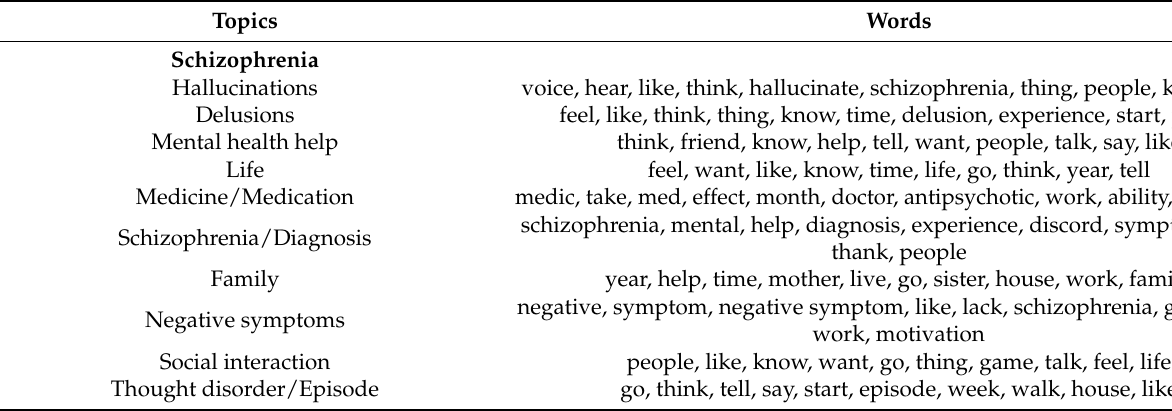
Table 3. Manually labeled topics and the top 10 words associated with each topic extracted from the schizophrenia and non-schizophrenia (control)